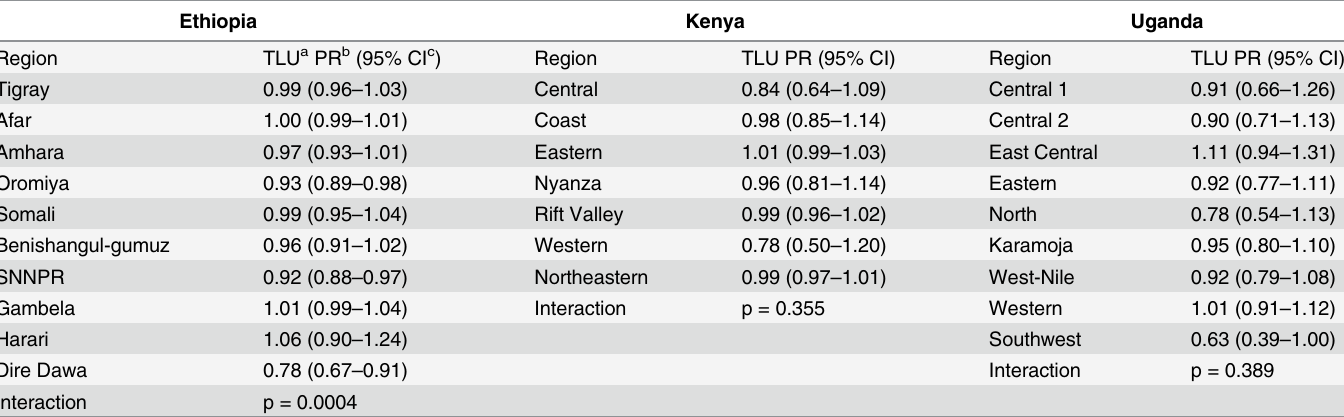
Table 4. Log-binomial models for the relationship between household livestock ownership and stunting prevalence, as stratified by region. Ethiopia